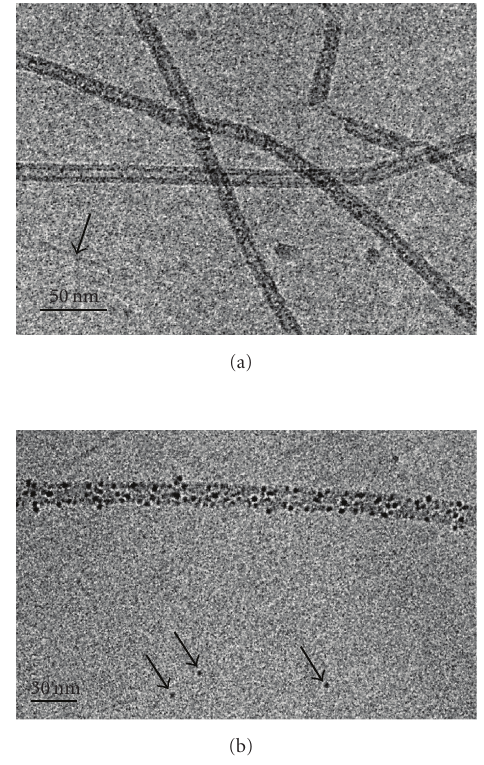
Figure 3: (a) Cryo-TEM image of C8S3 aggregates after addition of Na 2 PdCl 4 without any redactor ([C8S3] = 5 × 10 − 4 mol · l − 1 ; [Na 2 PdCl 4 ] = 1 . 3 × 10 − 6 mol · l − 1 ). (b) Same conditions as in (a), but after addition of